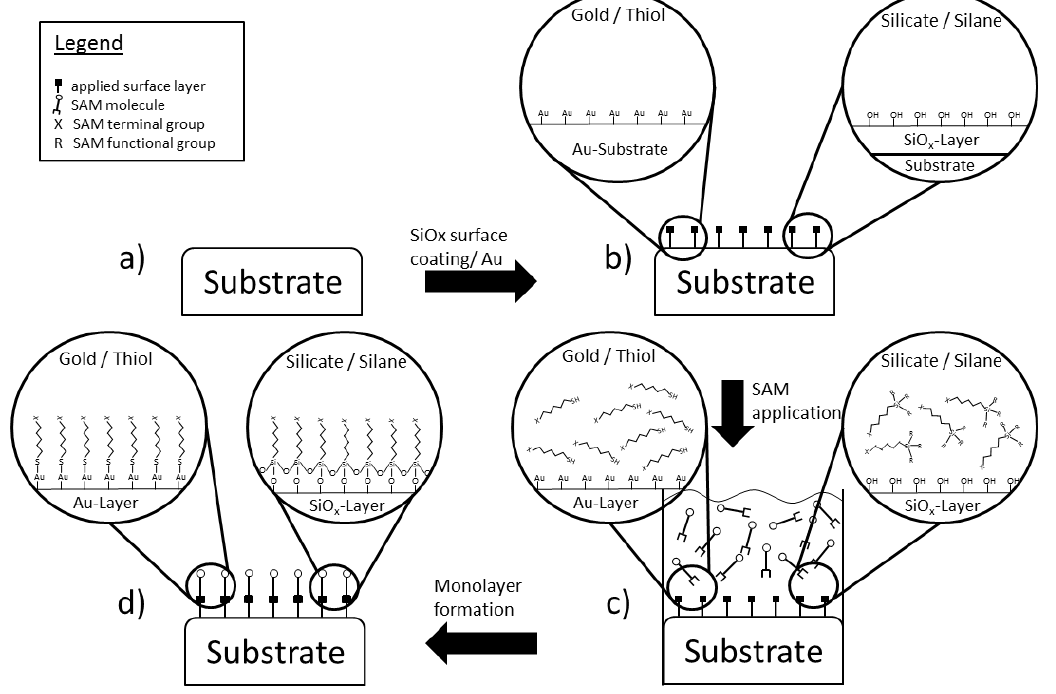
Figure 1. The general assembly scheme for the generation of a Self-Assembled Monolayers (SAM) on an inert surface is depicted with respect to a silicate-silane and a gold-thiol monolayer assembly. Please keep in mind that this scheme is meant to serve as a very abstract joint representation for two completely independent complex processes. ( a ) An originally inert surface is unable to house any further surface modification without prior onto the ceramic surface, this additional activation; ( b ) by depositing a layer of Si/SiO x activation becomes possible; ( c ) the SAM itself is applied through the addition of a solution holding the desired molecules in such a way that a surface attachment is only possible in one specific direction; ( d ) after the reaction, the solution is retracted and an originally inert surface has been chemically activated and is capable of housing further molecules of various